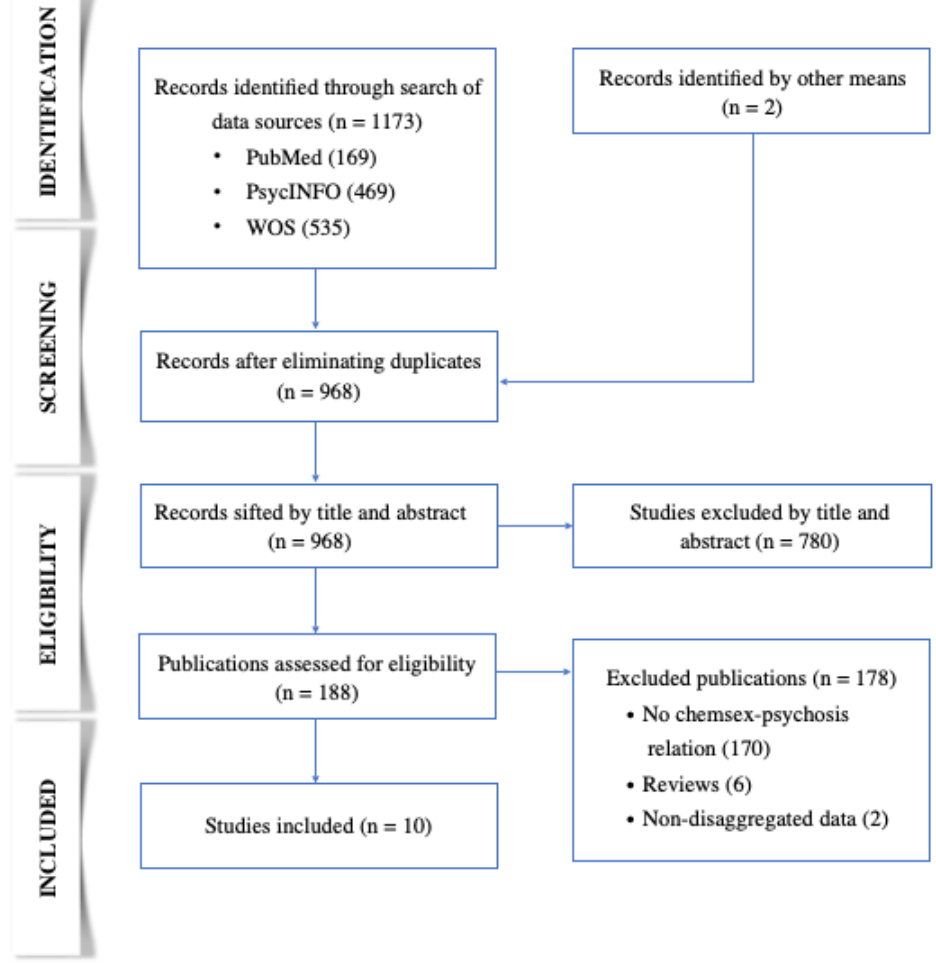
Figure 1. PRISMA diagram illustrating the article selection process.